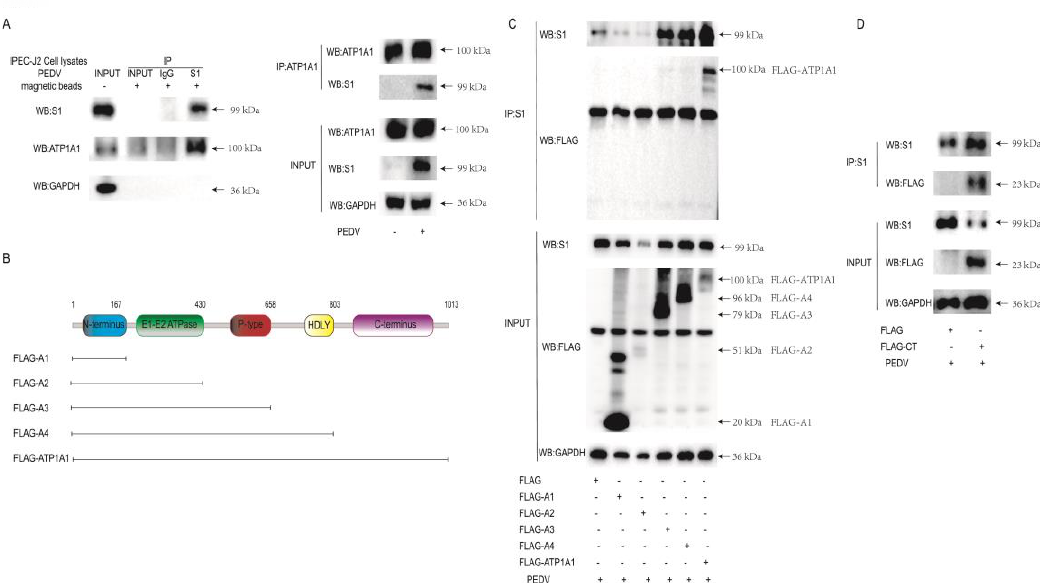
Figure 1. The ATP1A1 CT structural domain is required for the interaction with PEDV S1. ( A ) PEDV S1 interacts with endogenous ATP1A1 protein. PEDV at 0.1 MOI infected IPEC-J2 cells for 36 h. Western blot of CO-IP with mouse anti-S1 mAb and rabbit anti-ATP1A1 mAb. ( B ) The schematic diagram of the truncated structural domains of ATP1A1. ( C ) Full-length ATP1A1 interacted with S1 protein. Full-length ATP1A1, truncated A1, A2, A3 and A4 structural domains were transfected, fy, to Vero-E6 cells for 24 h and then PEDV at 0.1 MOI infected cells for 24 h. Western blot of co-immunoprecipitations from lysates with mouse anti-S1 mAb and mouse anti-FLAG mAb. ( D ) ATP1A1 CT domain interacted with S1 protein. Vero-E6 cells were transfected with the plasmid expressing ATP1A1-CT for 24 h and were infected with PEDV at 0.1 MOI for 24 h. Western blot of co-immunoprecipitations from lysates with mouse anti-S1 mAb and mouse anti-FLAG mAb.